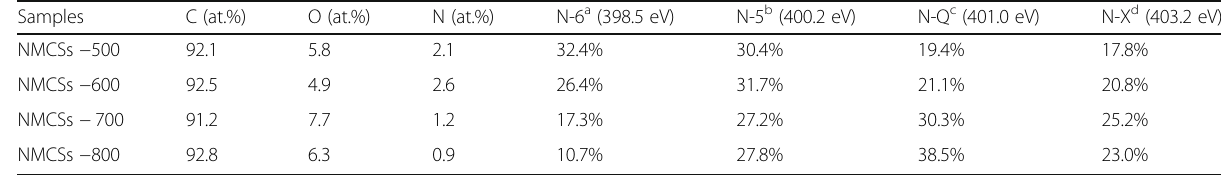
Table 1 XPS for the elemental composition analyses of NMCSs and the relative ratios of nitrogen species to the total N 1 s Samples C (at.%) O (at.%) N